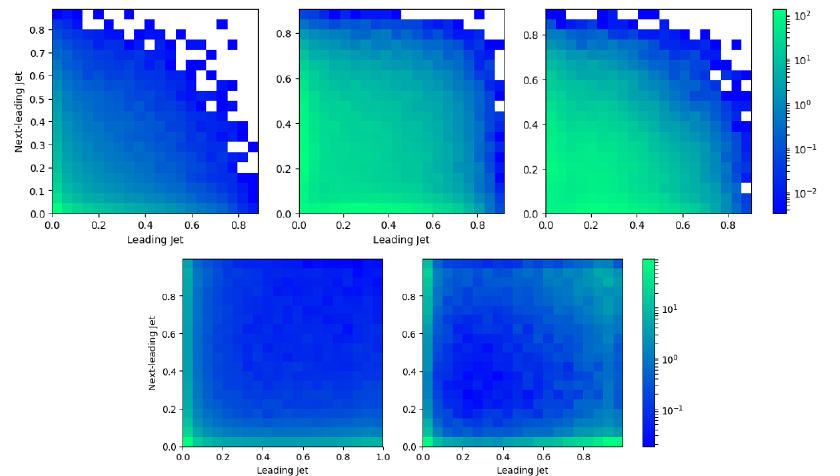
Figure 4 . Top: jet tagger-assigned probabilities of leading and subleading jet being a \QCD jet", in the three samples (left to right: signal, hjj , and (cid:13)(cid:13)jj ). Bottom: jet tagger-assigned probabilities of leading and subleading jet being a top jet, in the signal (left) and tth (right) samples. Green/light pixels correspond to higher event rate, while blue/dark pixels correspond to lower event rate.